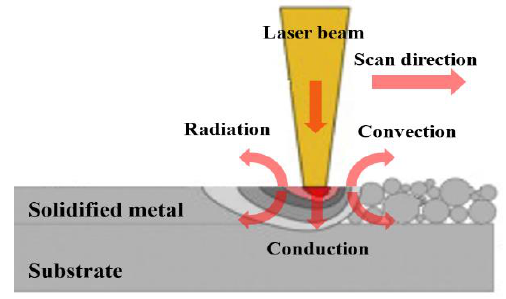
Figure 1. Schematic of thermal behaviour of powder bed under laser irradiation.